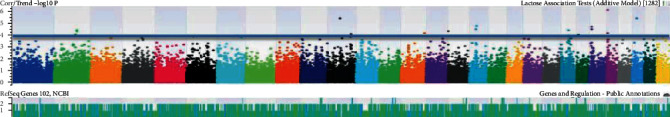
Identification of genomic coordinates on Manhattan plots associated with lactose in the chromosomes of Capra hircus.